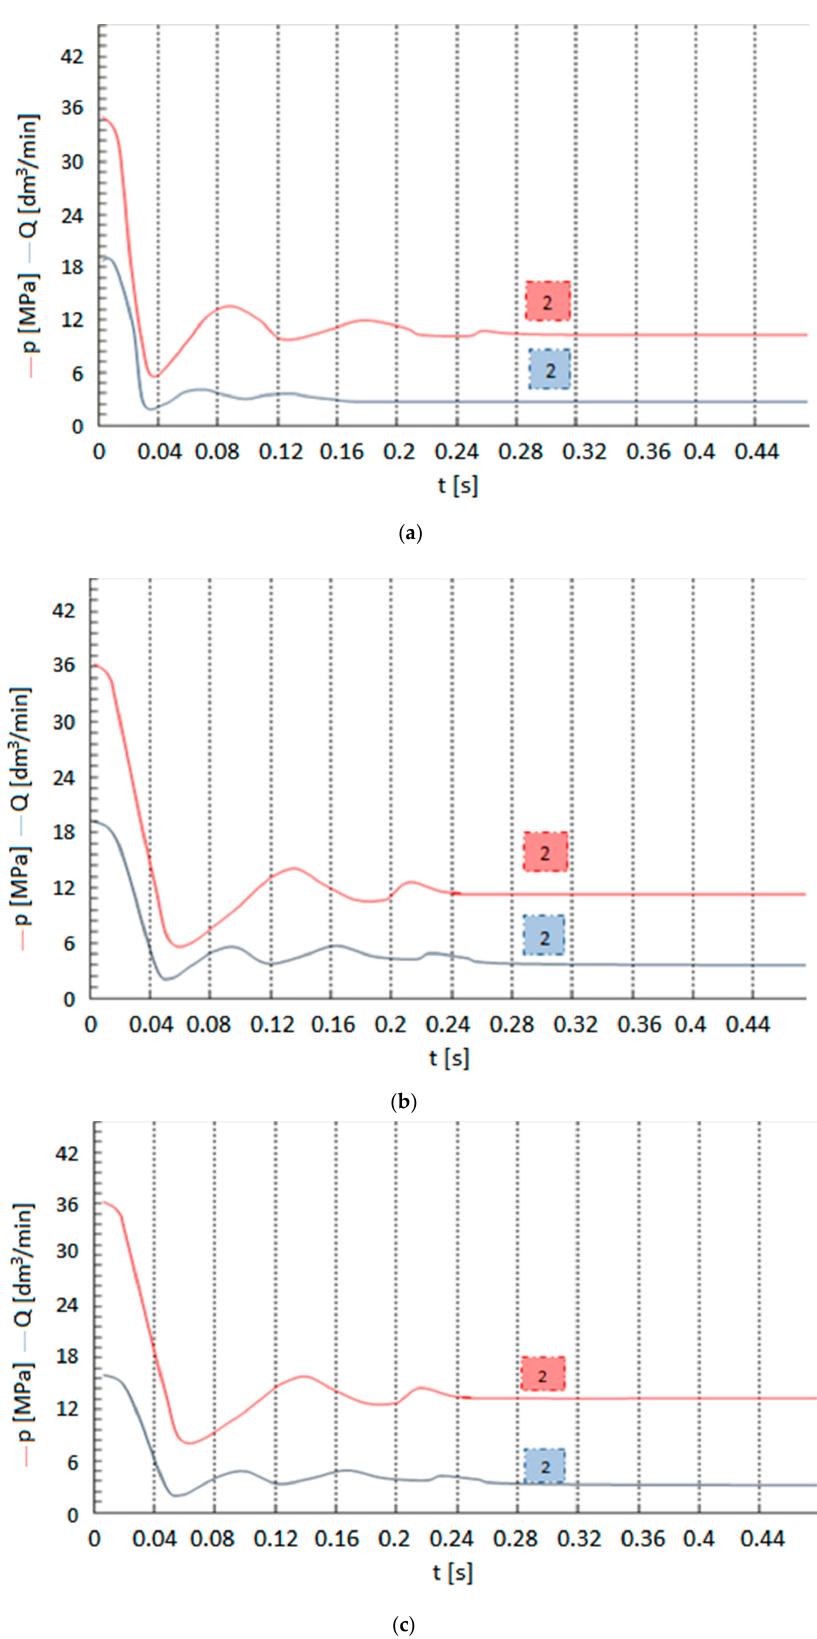
Figure 11. The Q and p time periods for code changes of the K p1 ·K p2 , Q rz , F m parameters, Q rz : ( a ) 2(122), ( b ) 2(322), ( c ) 2(222). Runs for a weighting factor value of w i = 2.